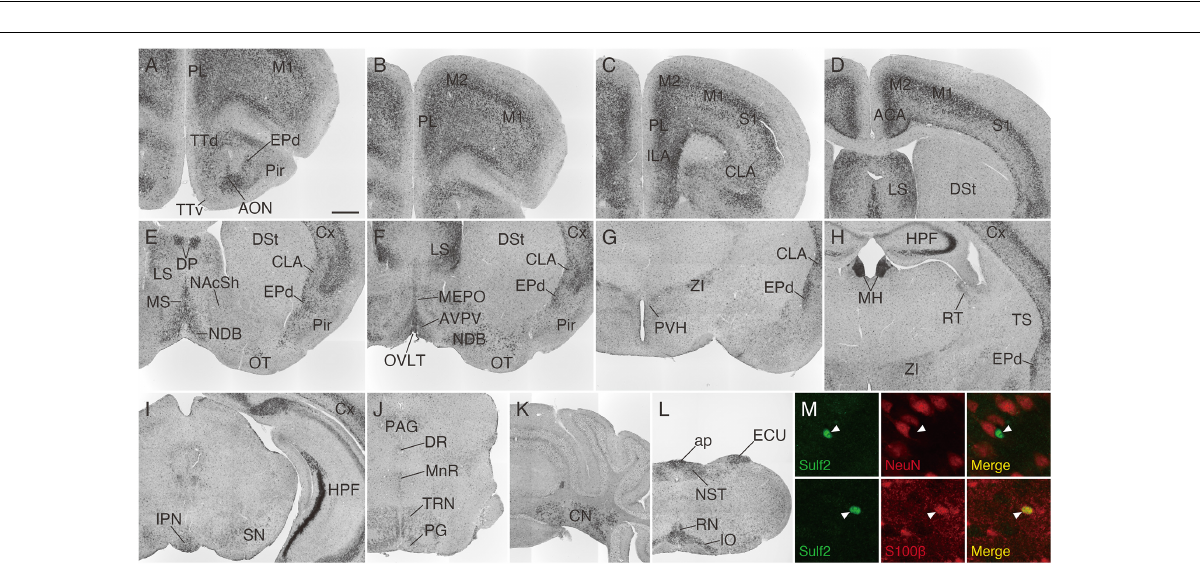
FIGURE 6 | Sulf1 mRNA expression in the midbrain, cerebellum, and lower brainstem. (A,B) Sulf1 was expressed in the raphe nuclei (RN) in the midbrain, including the dorsal (DR) and median raphe (MnR) nuclei, and part of the ventral tegmental area (VTA). (C) In the cerebellum, Sulf1 expression was seen in the Purkinje cell layer (Pu). (D) The area postrema (ap) was strongly labeled. (A 1 –D 1 ) Show the enlarged images in the boxed areas in (A–D) , respectively. Aq, aqueduct; CN, cerebellar nuclei; Cx, cerebral cortex; HPF, hippocampal formation; IPN, interpeduncular nucleus; mlf, medial longitudinal fasciculus; PAG, periaqueductal gray; SN, substantia nigra. The scale bars indicate 500 µ m (A–D) and 200 µ m (A 1 –D 1 ) . Approximate AP levels from the bregma (in mm) are –3.5 (A) , –4.5 (B) , –6.5 (C) , and –7.5 (D) .